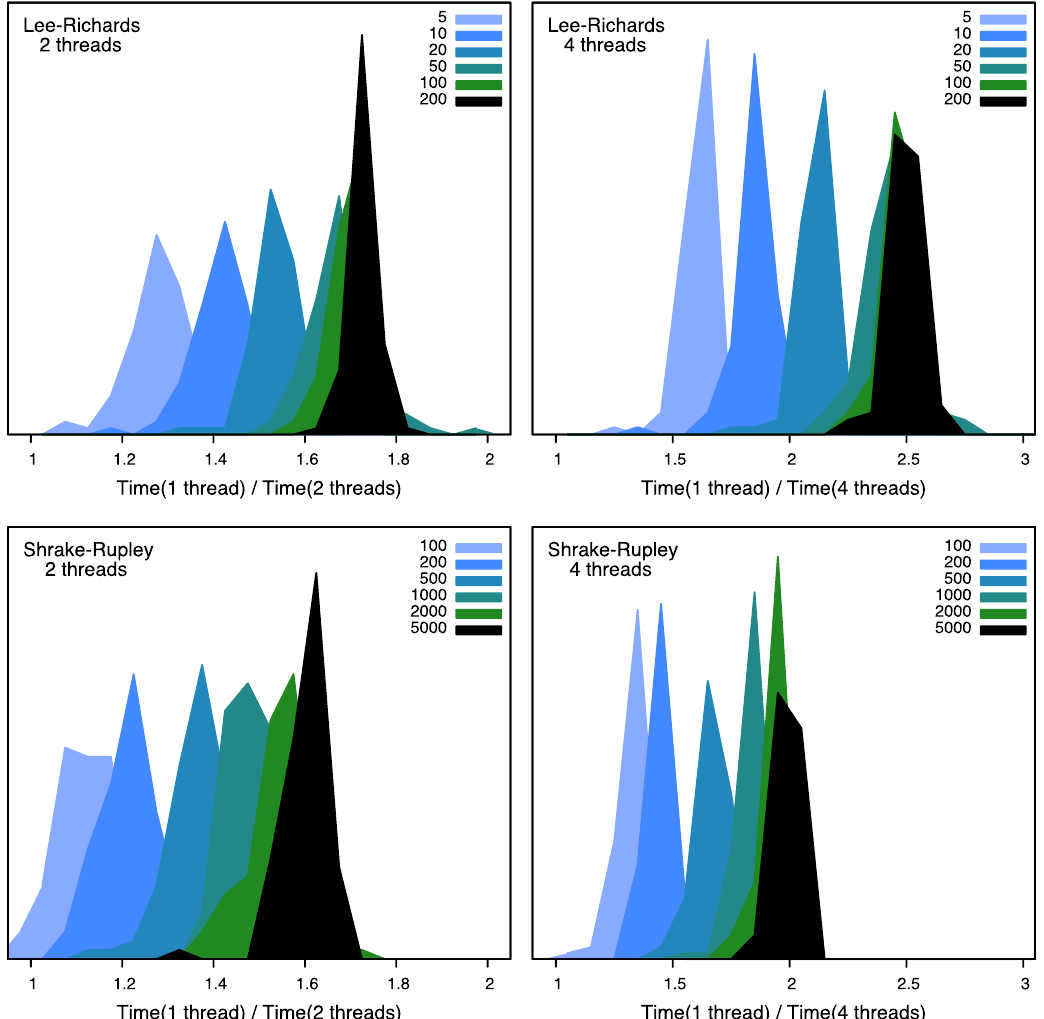
Figure 3. Parallelization. The histograms shows the distribution of the calculation time using two or four threads divided by the time using one thread. Thus if this fraction is two or four, respectively, we have “perfect” parallelization. The legends indicate the resolution of the calculation: for L&R, slices per atom, and for S&R, number of test points. The raw data for this figure can be found in Dataset